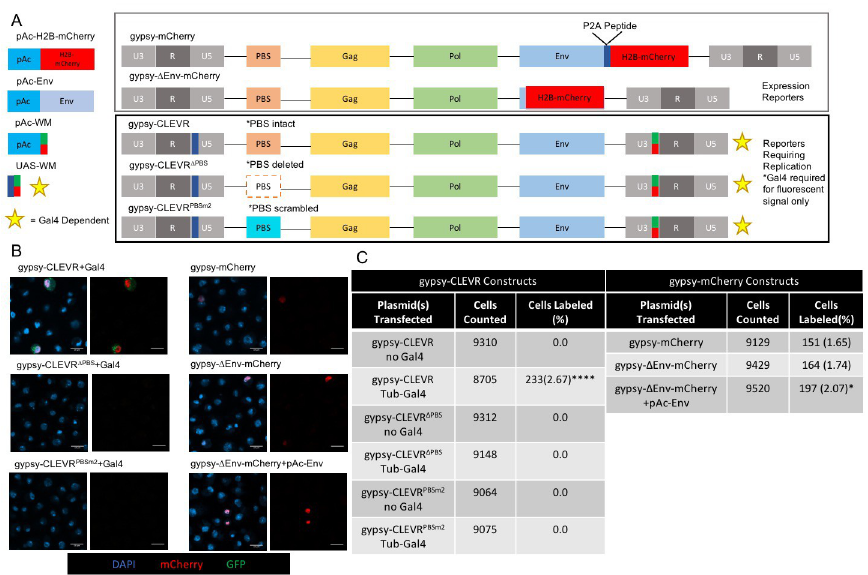
Fig 1. Functional test of reporters marking gypsy replication and expression in Drosophila S2 cells. (A) Cartoon representations of the pAc-H2B-mCherry, pAc-Env, pAc-WM, UAS-WM, gypsy-CLEVR, gypsy-CLEVR Δ PBS , gypsy- CLEVR PBSm2 ,(PBS deleted and replaced with a scrambled sequence of the same length (11)) gypsy-mCherry, and gypsy- Δ Env-mCherry constructs used. The P2A site between Env and mCherry in the gypsy-mCherry construct is denoted in blue. UAS insertion site in gypsy-CLEVR denoted in blue. mCherryP2AmCD8GFP denoted with red/green swatch. Star denotes Gal4 dependence for fluorescence but not replication. (B) Fluorescent images showing WM or mCherry positive S2 cells for gypsy-CLEVR and gypsy-mCherry constructs detected 48 hours after transfection. Scale bars = 10 μ m. (C) Quantification showing the percentage of cells labeled for the gypsy-CLEVR constructs with and without Gal4, and the gypsy-mCherry constructs. Quantification is presented as totals cells counted from 3 near equivalent sets of biological replicates. Significance for the gypsy-CLEVR constructs was calculated against gypsy- CLEVR with no Gal4; significance for gypsy-mCherry constructs was calculated against gypsy-mCherry. Significance was determined using the Fisher’s Exact test variant of the Chi 2 test. Significance values are denoted as: p = < 0.05 � , p = < 0.001 ��� , p = < 0.0001 ���� Raw data for cell counts shown in S1 Table.